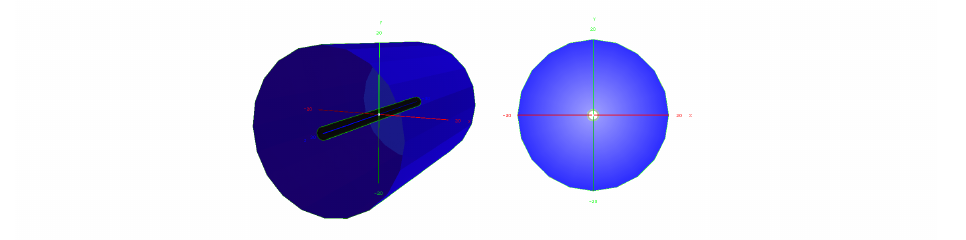
Figure 7. TPC Inner Tracker, described in the DD4HEP simulation.